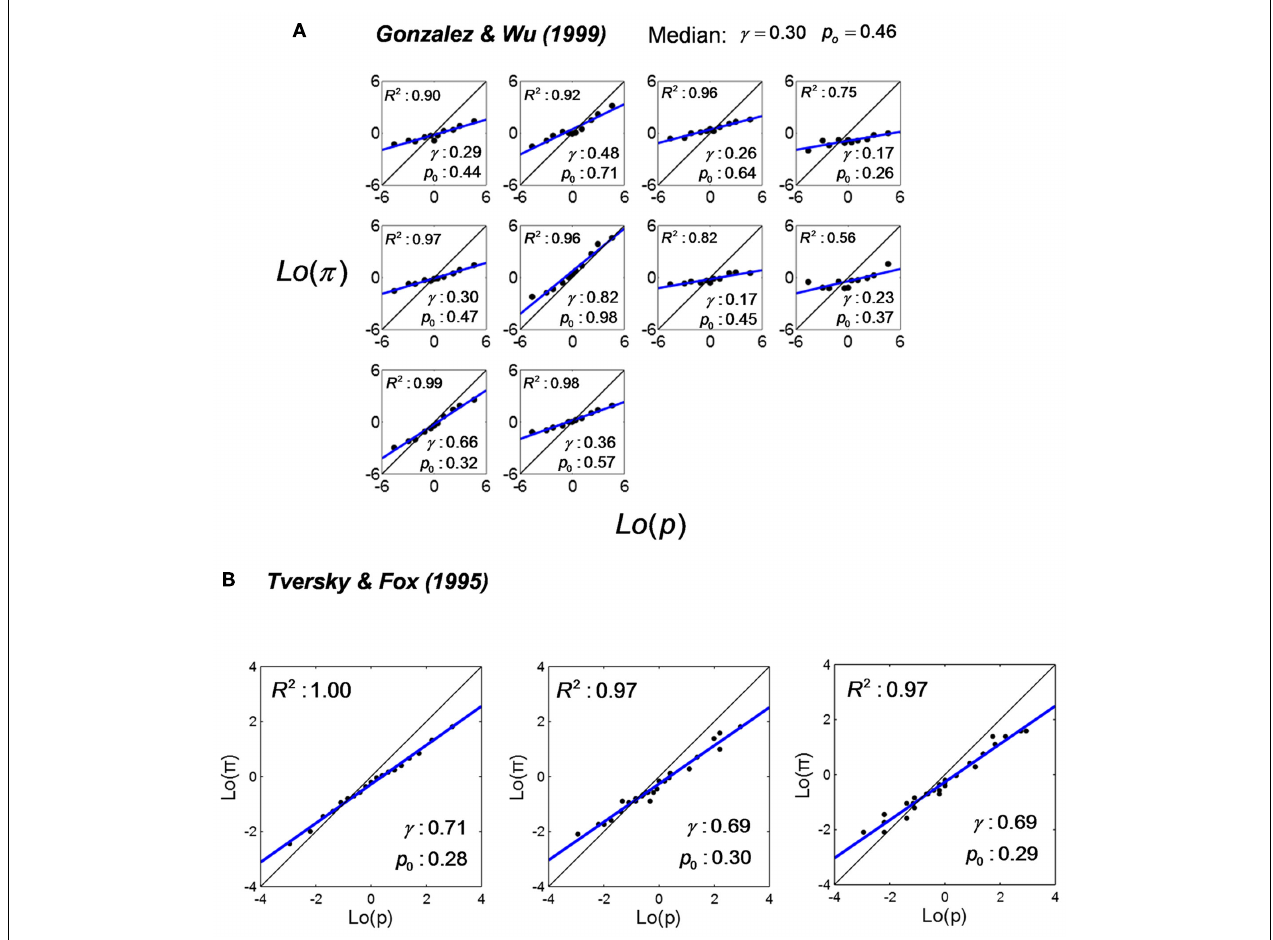
Theory. Re-plotted from Figure 6 of Gonzalez andWu (1999). (B) Decision weights fromTversky and Fox (1995). Participants chose between a lottery offering a probability of a reward or otherwise zero and a sure reward.The probability of winning the larger reward of the lottery p was stated (left panel), or estimated by participants themselves as the probability of a specific Super Bowl prospect (middle panel), or as the probability of a specific Dow-Jones prospect (right panel). Decision weight, the counterpart of subjective probability π , was inferred from participants’ choices based on the Cumulative ProspectTheory Re-plotted respectively from Figures 7–9 ofTversky and Fox